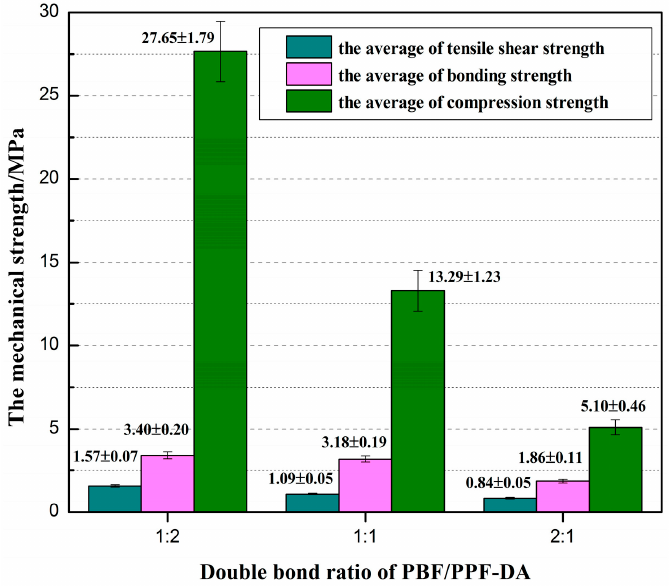
Figure 9. The tensile-shear, bonding, and compression strengths of the PBF/PPF-DA polymer networks with double-bond ratios 0.5, 1, and 2 (error bars represent mean ± SD for n = 5).